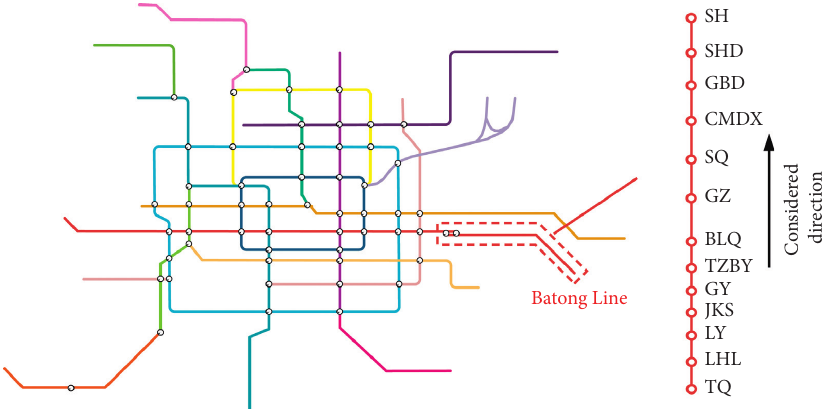
Figure 6: Batong Line in Beijing subway network.